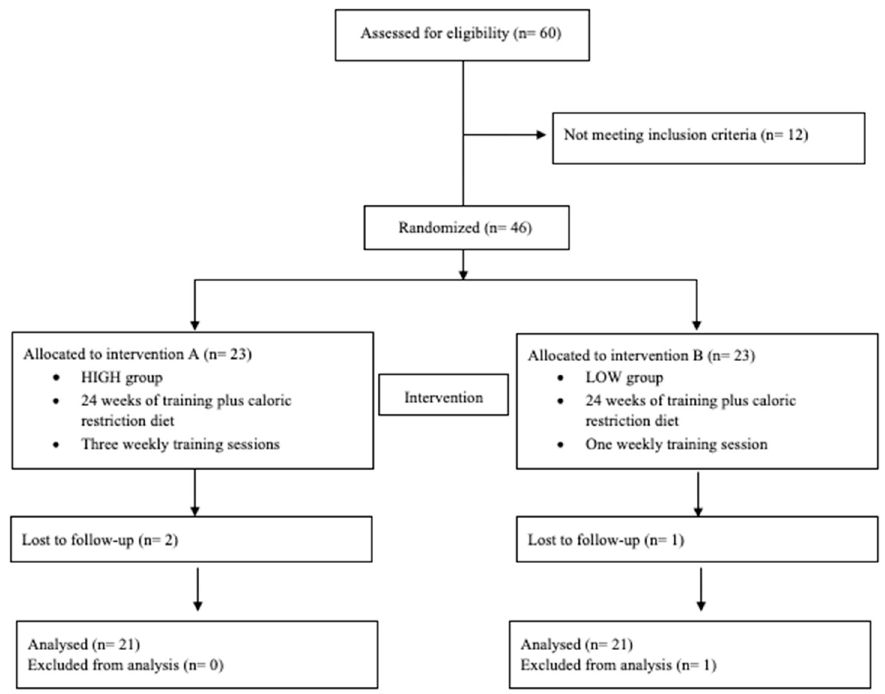
Figure 1. Flow chart.